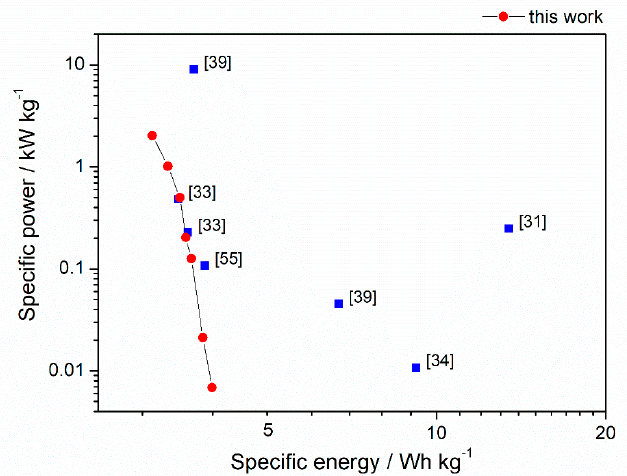
Figure 9. Ragone plot showing the comparison between the specific energy and power obtained for activated carbon from horse chestnut seeds (this work) and chestnut-shells (literature).